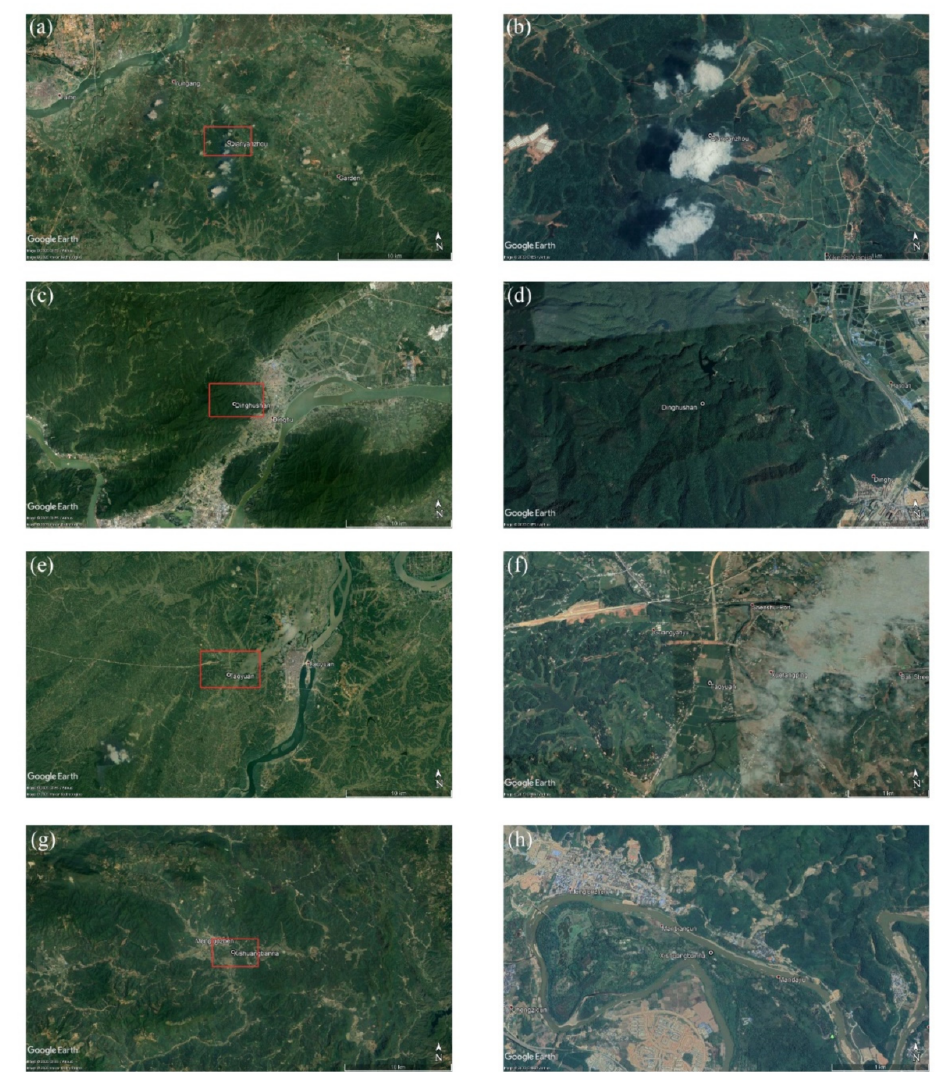
Figure A1. High-resolution satellite imagery (Google Earth) of the surrounding areas of the four flux stations listed in Tab. 1. The position of the stations is in the center and marked by the black-circle dots. ( a , b ) Qianyanzhou, ( c , d ) Dinghushan, ( e , f ) Taoyuan, and ( g , h ) Xishuangbanna. The left and right column is at the scale of 10 km and 1 km, respectively. The red rectangles in the left column mark the areas in the right column. The scale legend and north arrow is located at the bottom right